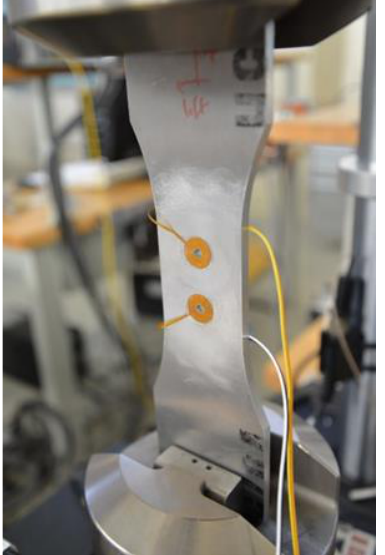
Figure 3. Photograph of the test coupon; the fatigue crack was expected to grow from the lower hole.